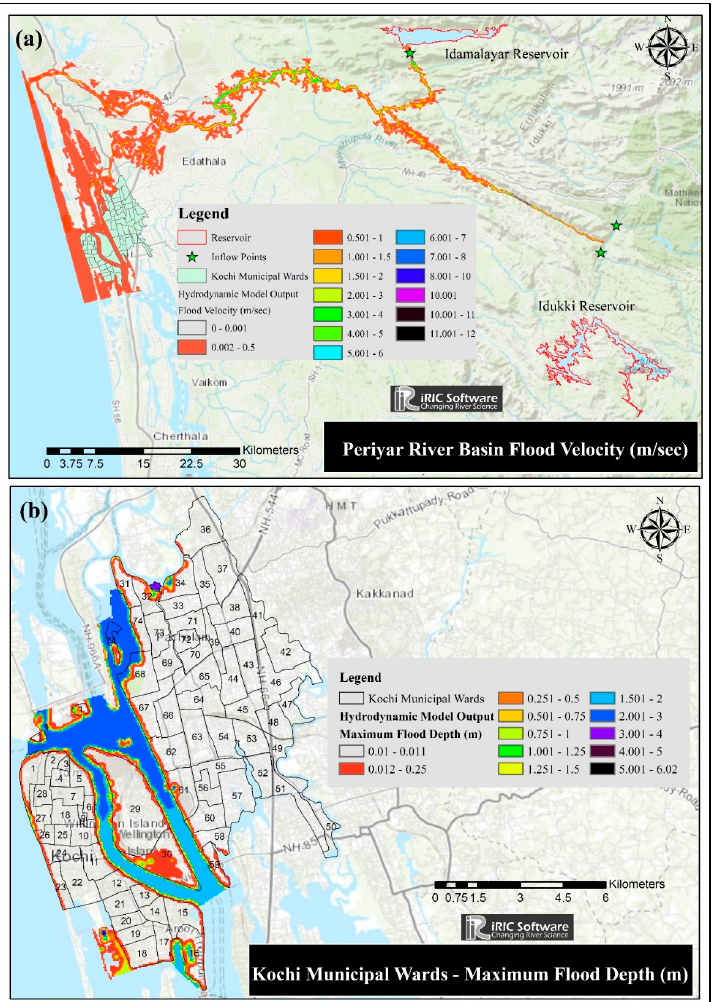
Figure 10. Hydrodynamic model flood depth output of Kochi city and flood velocity of Periyar river basin under controlled flow condition (with reservoir operation) where ( a ) shows the flood velocity in Periyar River Basin and ( b ) shows maximum flood depth in the Kochi Municipal In Scenario 2, 2D iRIC was developed using natural flow condition without considering reservoir operation. Figure 11 explains the flood depth obtained from the model under natural flow condition. Figure 11a displays the developed 2D hydrodynamic model of Periyar river basin with flood water depth. Whereas Figure 11b displays the flood water depth in Kochi city. The result shows that the flooding depth in Kochi city is less ranging from 0.012 m to 1.5 m whereas in the river basin the depth varies from 0.12